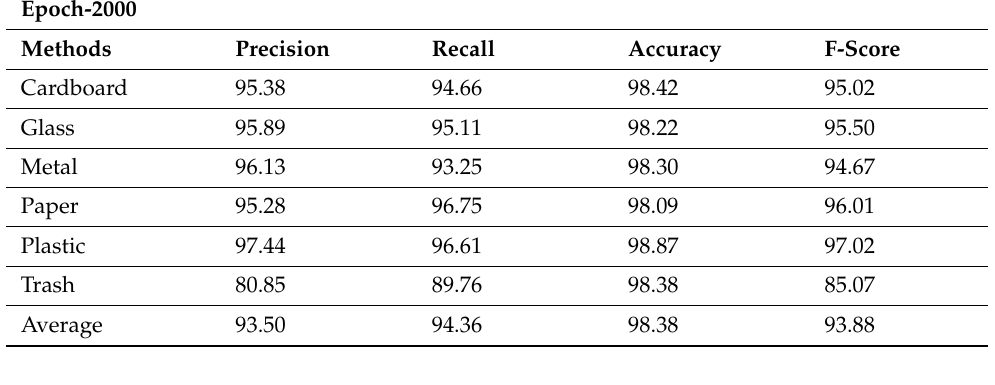
Table 2. Result analysis of DLSODC-GWM technique with different methods under 2000 epochs.